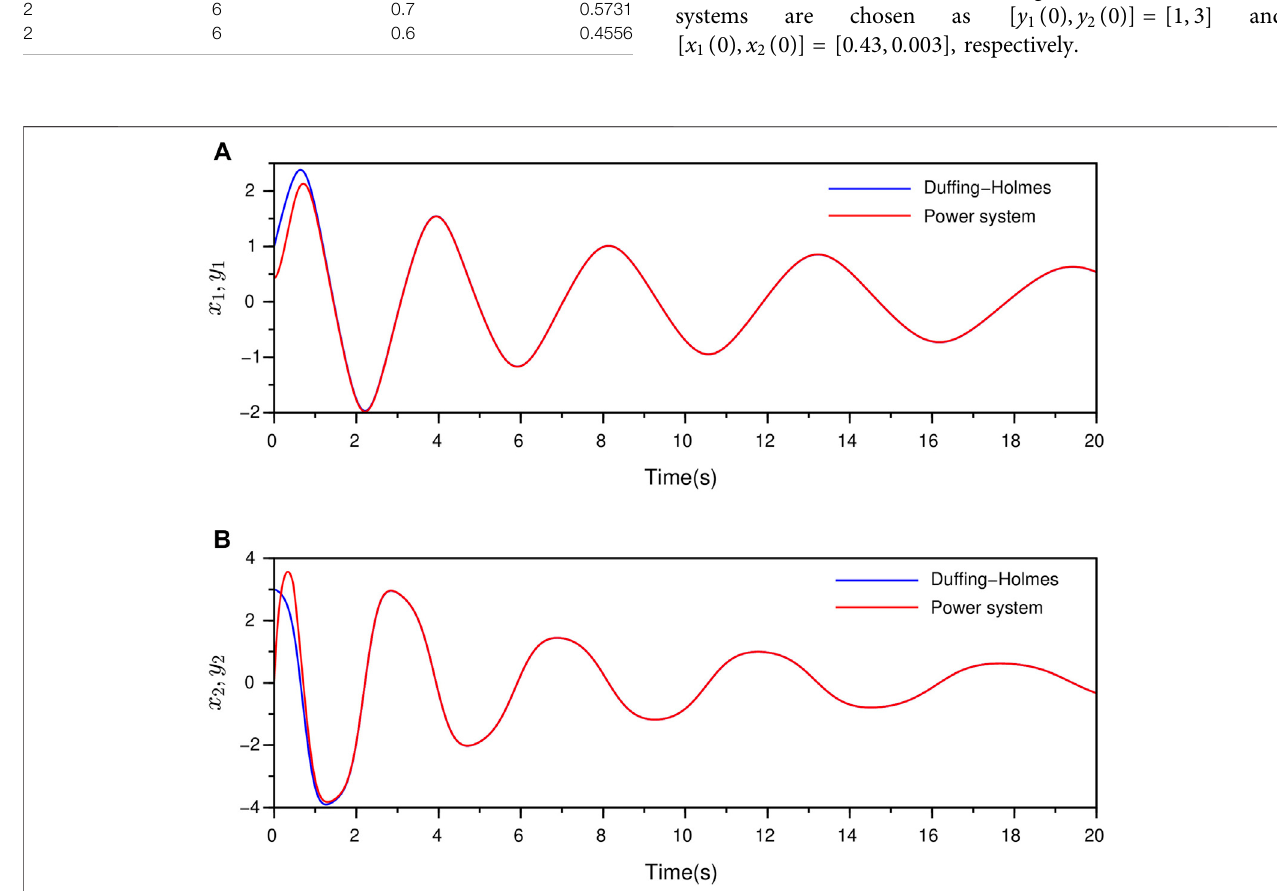
FIGURE 7 | Synchronization the Duf fi ng-Holmes and the Power systems in Example 2 by ANFTSM controller (A) the synchronization between x 1 and y 1 (B) the synchronization between x 2 and y 2